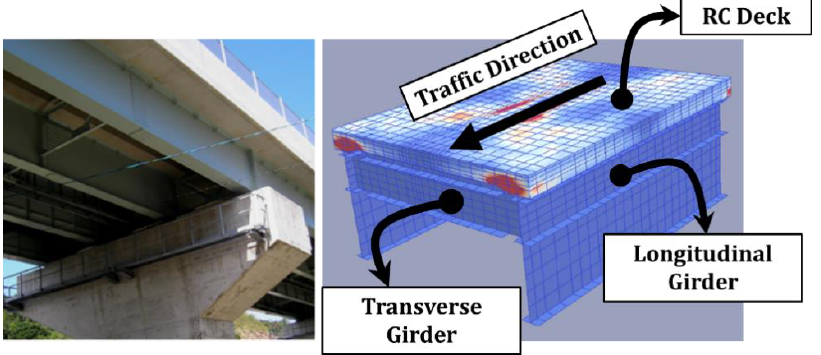
Figure 4. RC deck of road steel-girder bridges.